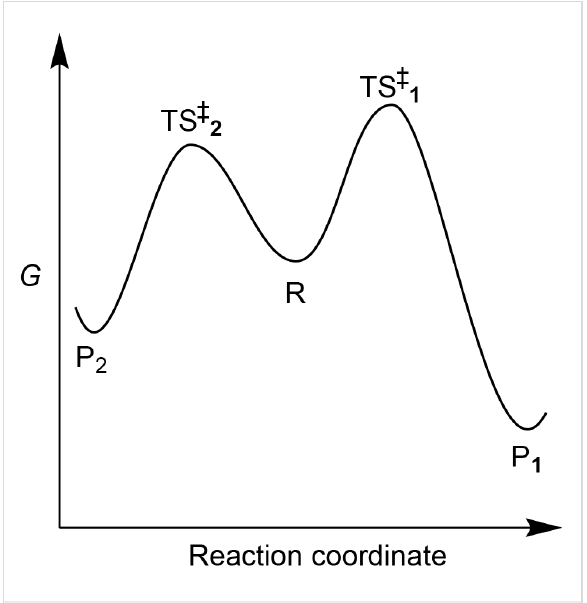
Figure 2: Kinetic control. In many chemical reactions leading to differ- ent products, the final composition is determined by the height of the kinetic barriers corresponding to transition states ( TS ‡ 1 and TS ‡ 2 ) rather than by the relative free energies of reactant ( R ) and products ( P 1 and P 2 ). Under kinetic control, P 2 would be favoured over P 1